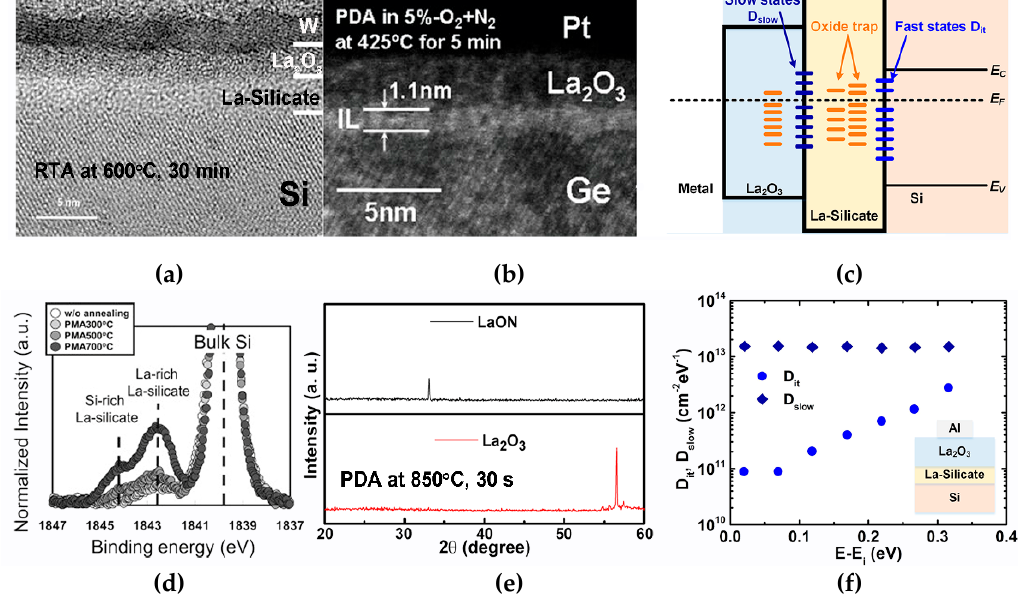
Figure 10. ( a,b ) TEM images of Si and Ge MOS structures with La 2 O 3 as a gate dielectric [55,56], ( c ) band diagram showing the traps in a metal/La 2 O 3 /La-silicate/Si gate stack [58], ( d ) calculated D it and D slow in the band gap of Si with E i as the midgap of the Si substrate [60], ( e ) Si 1s spectrum at the La 2 O 3 /Si interface for different annealing temperatures [57], and ( f ) XRD patterns of La 2 O 3 and LaON films after annealing [61] .